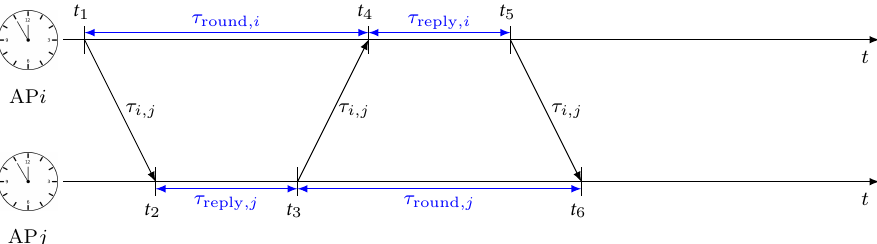
Figure 1. Message exchange with ADS-TWR